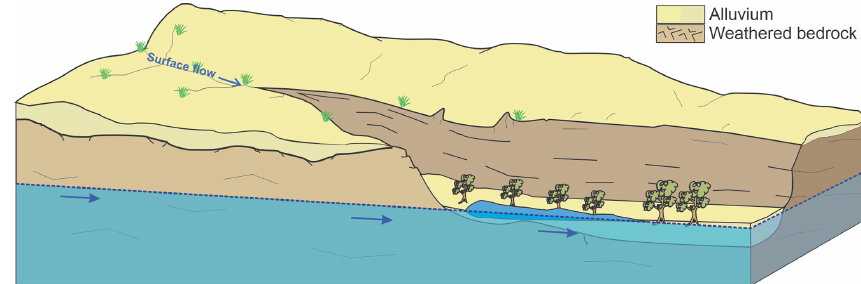
Figure 4. Schematic illustration of a pool receiving topographically-controlled groundwater outflow from a regional aquifer.